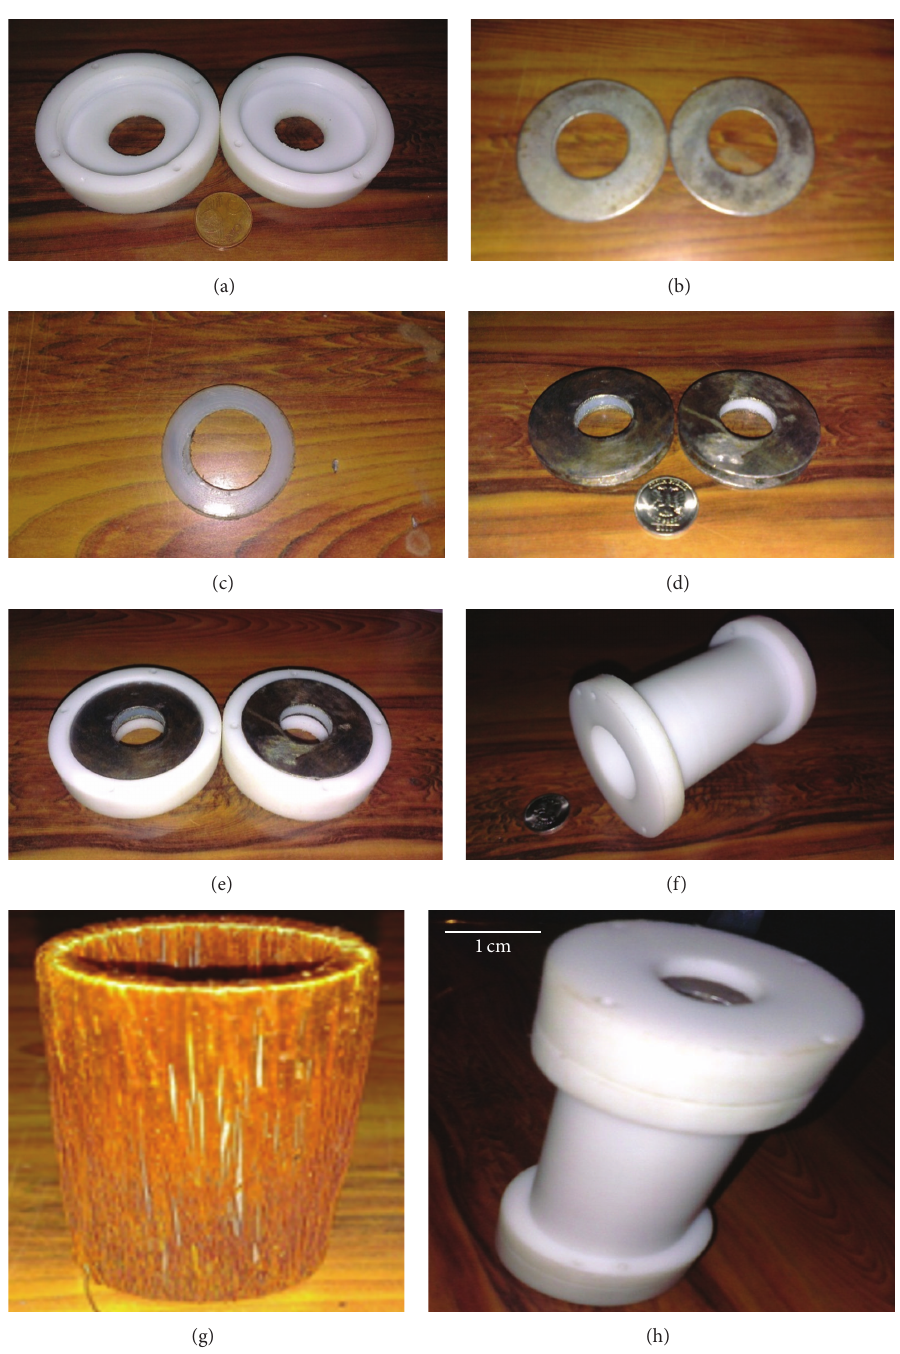
Figure 10: Fabrication of prototype-1: (a) capacitive energy harvester holder caps, (b) annular mild steel conductive plates, (c) Teflon spacer, (d) assembled capacitive energy harvesters, (e) capacitive energy harvesters in Teflon holder caps, (f) Teflon housing for inductive energy harvester, (g) copper wire wound around the cylindrical steel core, and (h) assembled prototype-1.